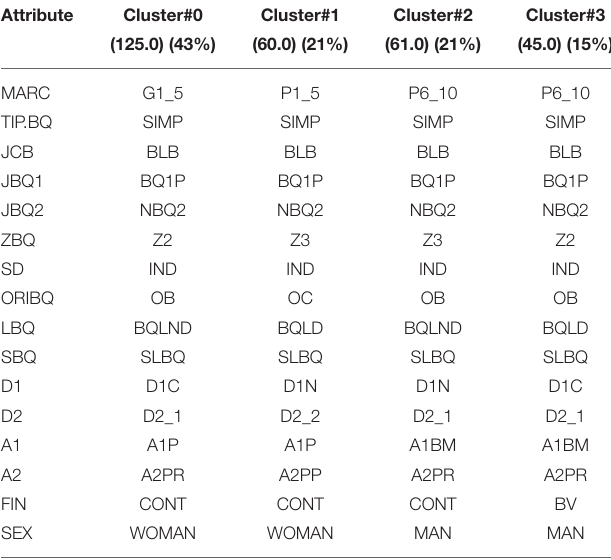
TABLE 7 | Results of the clustering of data.